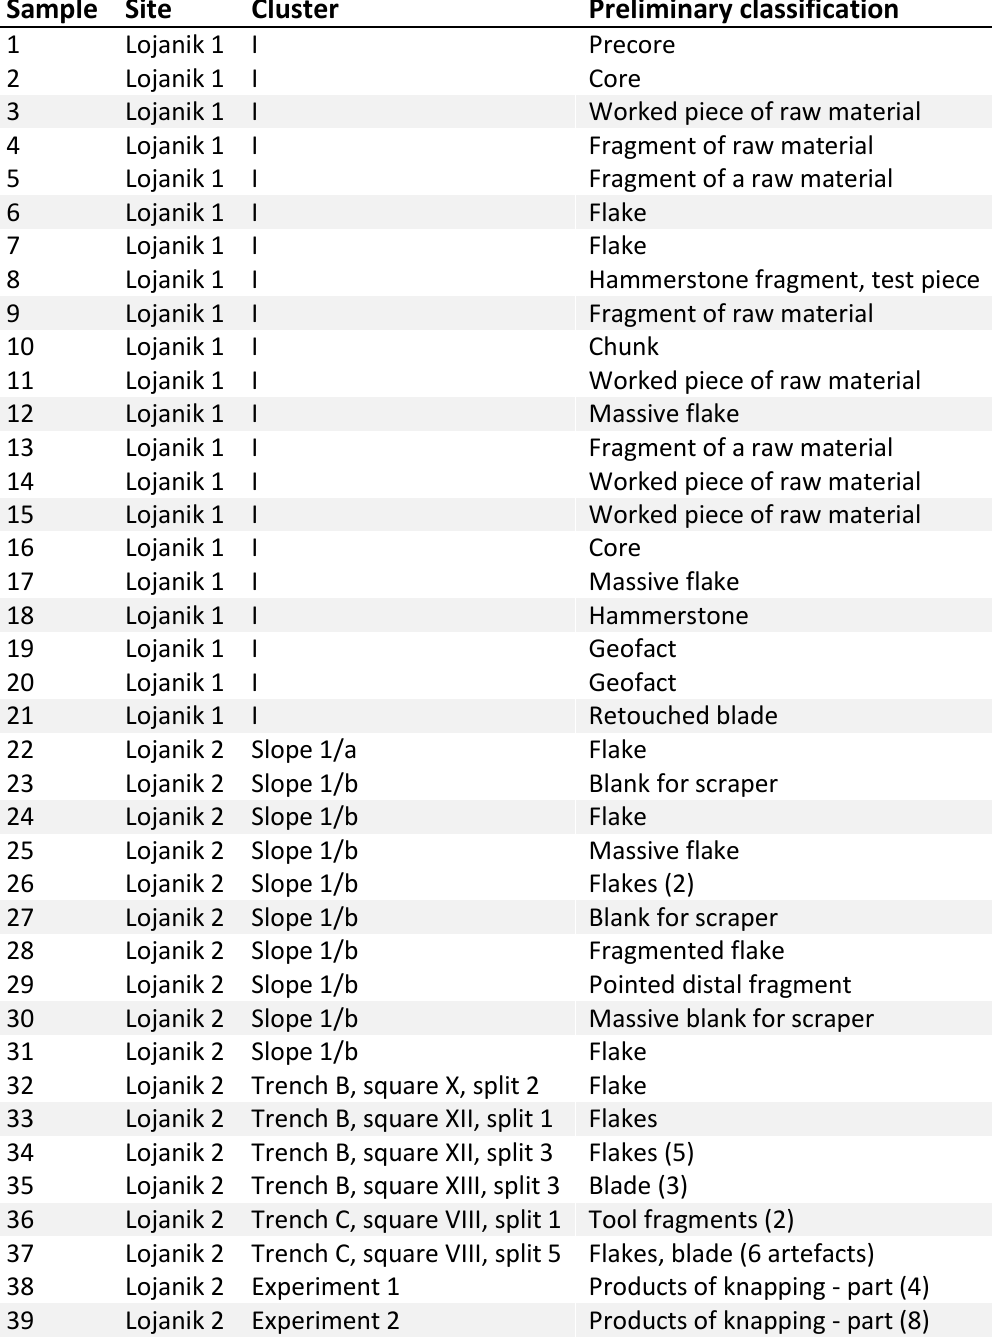
Table 1: List of